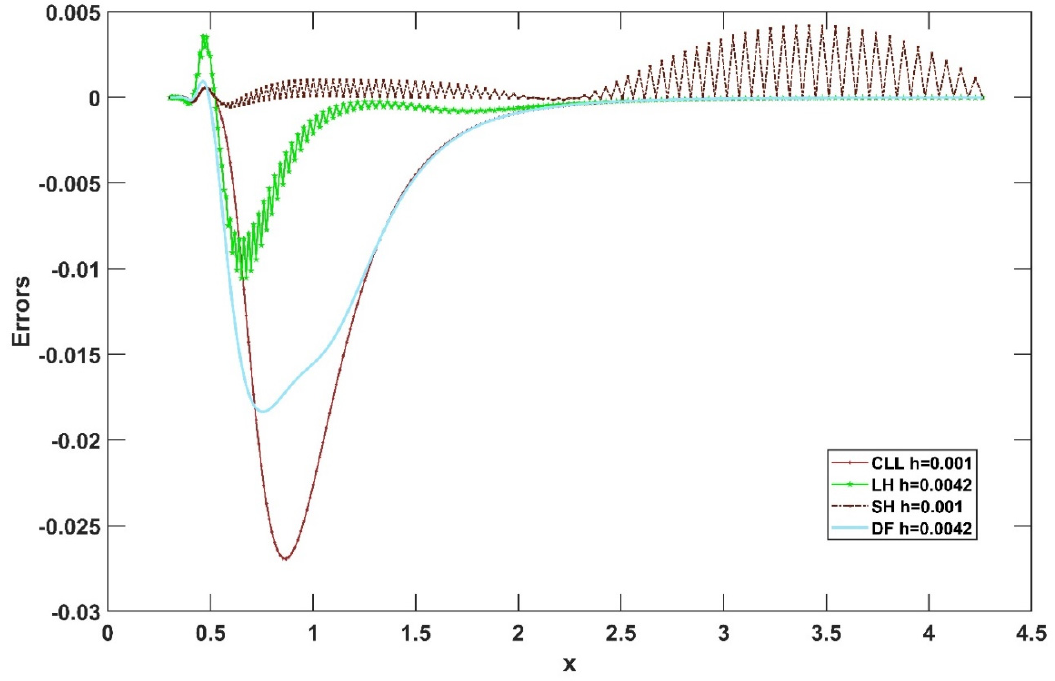
Figure 16. The errors of the cell concentrations as a function of the x variable in the case of the CLL and the SH method for h = 10 − 3 , and the LH and DF method h = 4.2 · 10 − 3 .